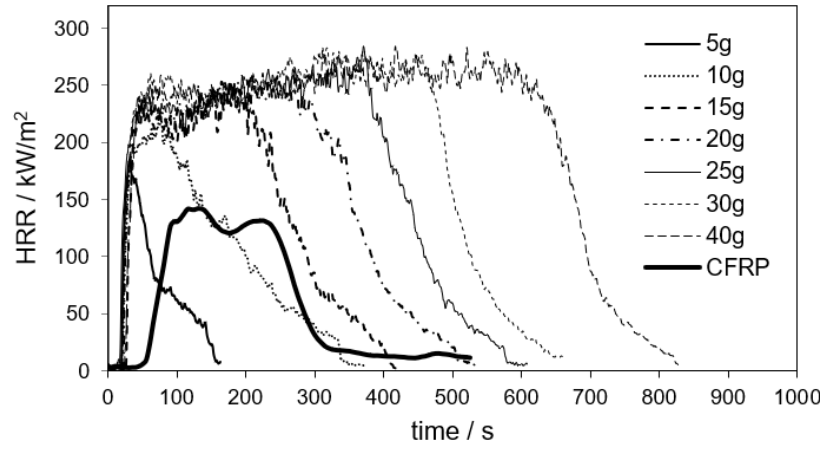
Figure 5. Exemplary heat release rate (HRR) curves for the combustion of various amounts of fire accelerant on CFRP samples. The HRR curve of the forced combustion of a 3 mm thick CFRP at an external heat flux of 60 kW/m 2 is added.